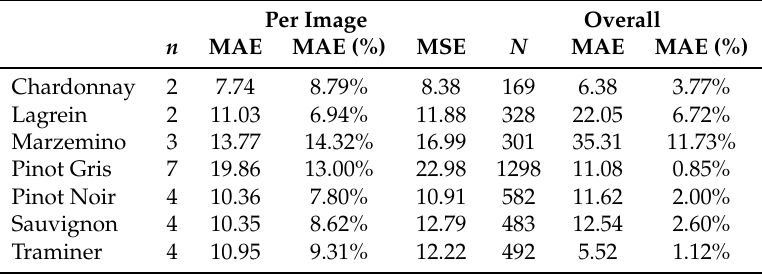
Table 6. Application of GBCNet on CR1 test dataset. Results are reported for each variety, with the number of images ( n ) and berries ( N ).